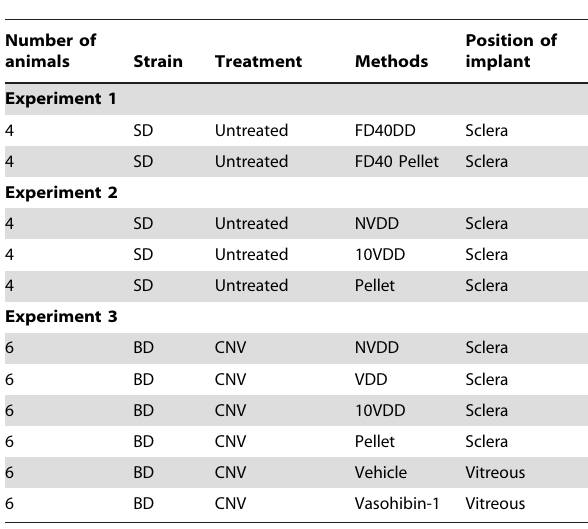
Table 1. In Vivo Study